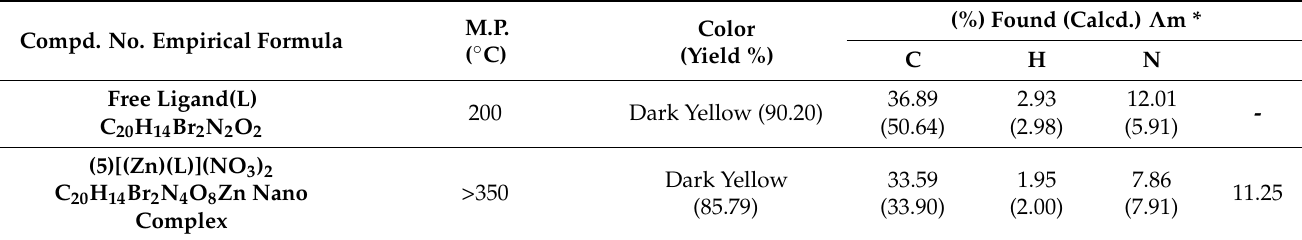
Table 1. Elemental analysis and some physical measurements of free ligand and its metal nano complex. Compd. No. Empiri- cal Formula